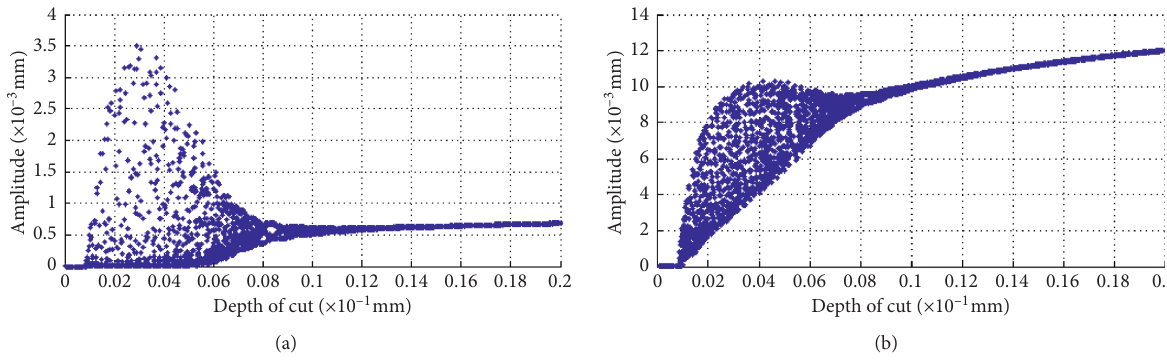
Figure 5: Bifurcation diagram of the grinding wheel displacement as a function of the depth of cut at the cutting speed of 25m/s. (a) Tangential direction. (b) Normal direction.